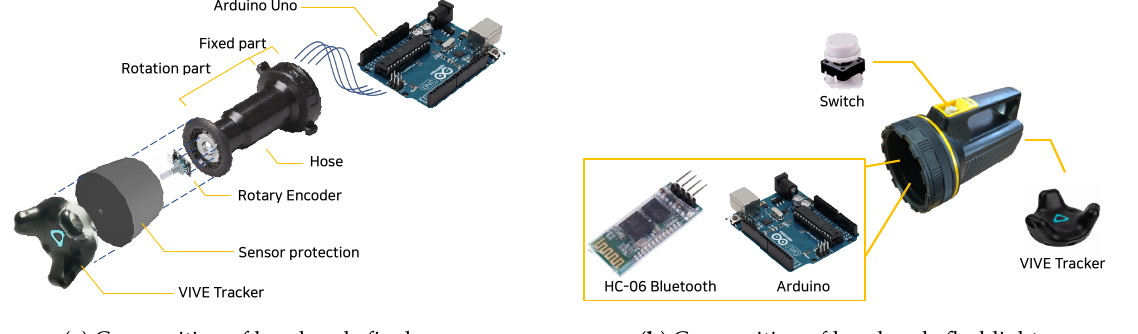
Figure 4. Composition of the ( a ) fire hose and ( b )